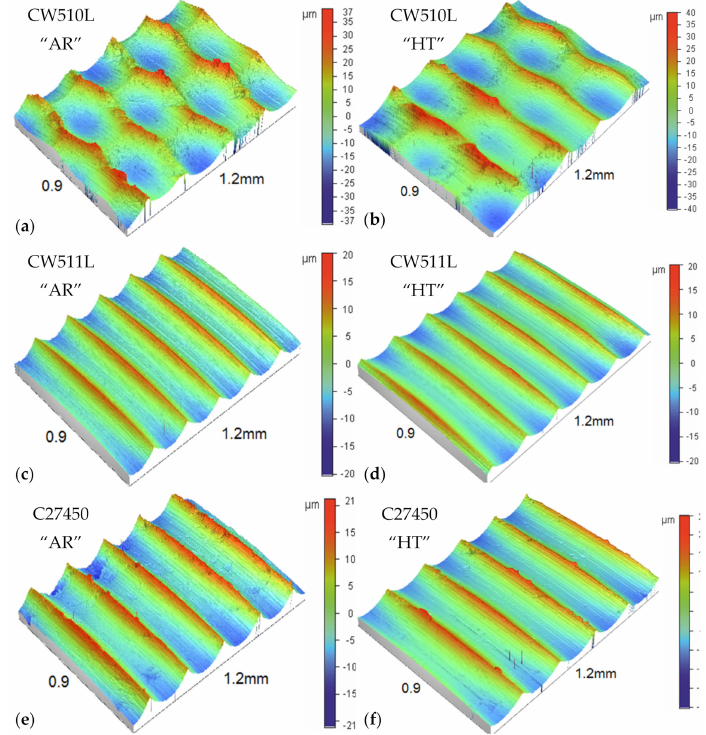
Figure 8. Surface topography derived from profilometric measurements: ( a ) CW510L, as received, ( b ) CW510L, heat-treated, ( c ) CW511L, as received, ( d ) CW511L, heat-treated, ( e ) C27450, as received and ( f ) C27450, heat-treated